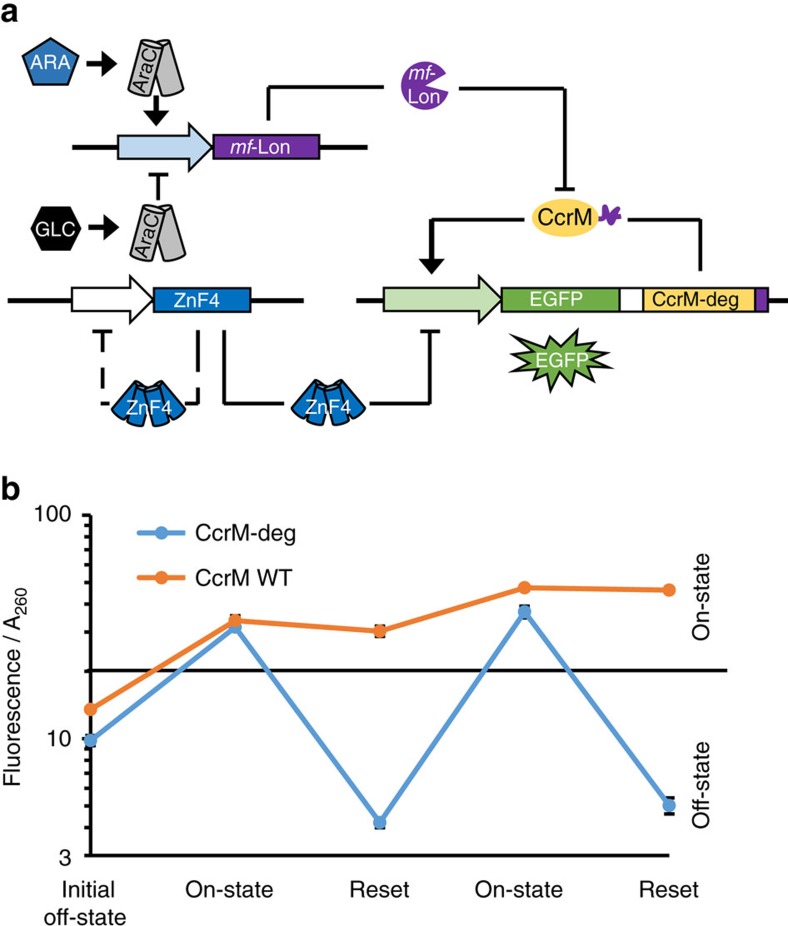
Signal reset of memory system IV.(a) Circuit design of the memory system including an inducible mf-Lon protease and a CcrM carrying a protein degradation tag (CcrM-deg), which leads to its specific degradation by mf-Lon. Afterwards, adenine-N6 methylation at GANTC sites is passively lost and the system returns to the off-state. (b) Experimental results of cycles of switching the memory system to the on-state by temperature induction and its return to the off-state by induced CcrM degradation (blue trace). The original system I containing wildtype CcrM without protein degradation tag did not respond to mf-Lon expression (orange trace). The figure shows stable steady-state signals in the corresponding phases for three individually cultivated clones (error bars indicate s.d., n=3 biological repeats). For a more detailed representation and additional control experiments, see Supplementary Figs 19 and 20.